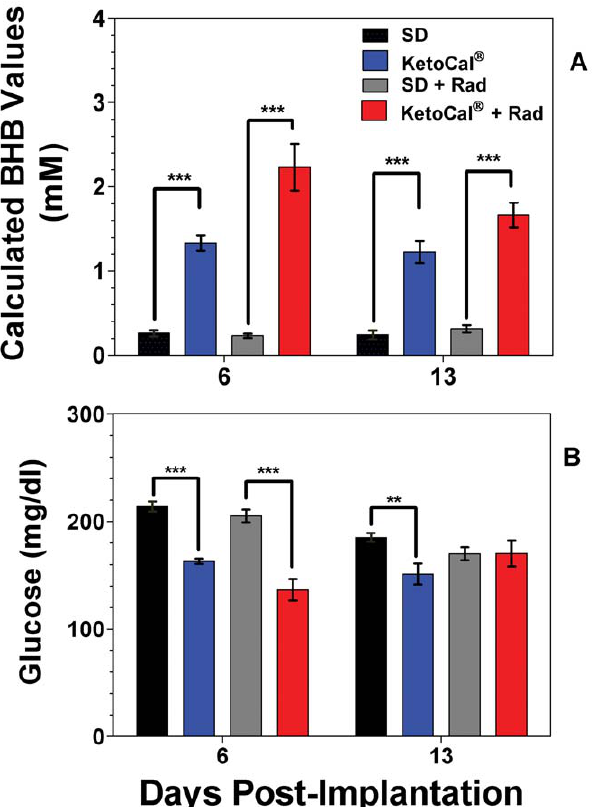
Figure 3. Blood ketone and glucose levels. Measurements of animal ketone and glucose levels show higher b HB blood levels in animals treated with KetoCal H . (A) b HB levels (B) Blood glucose measurements. **=p , 0.001; ***=p , 0.0001.